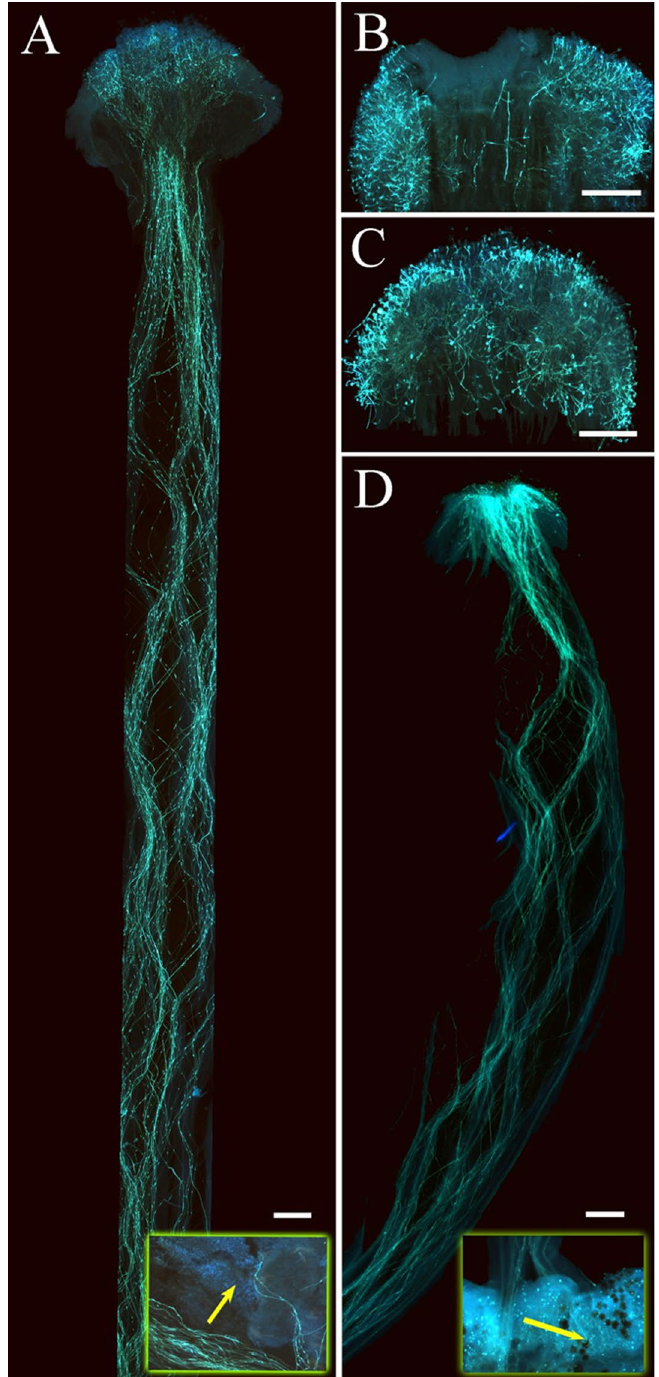
Figure 2. Guettarda speciosa pollen tube growth in vivo after hand pollination. ( A ) L-morph style 24 h after inter-morph pollination; ( B ) L-morph style 24 h after self-pollination; ( C ) S-morph style 24 h after self- pollination; ( D ) S-morph style 24 h after inter-morph pollination. Bar = 1